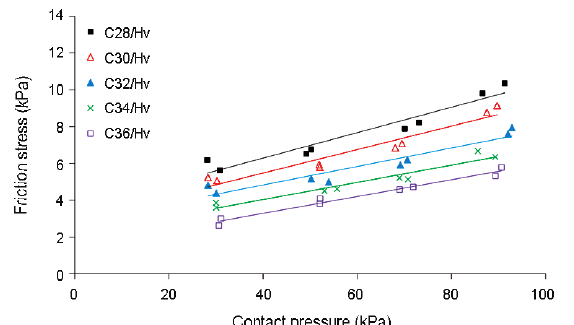
Fig. 19. Evolution of friction stress for